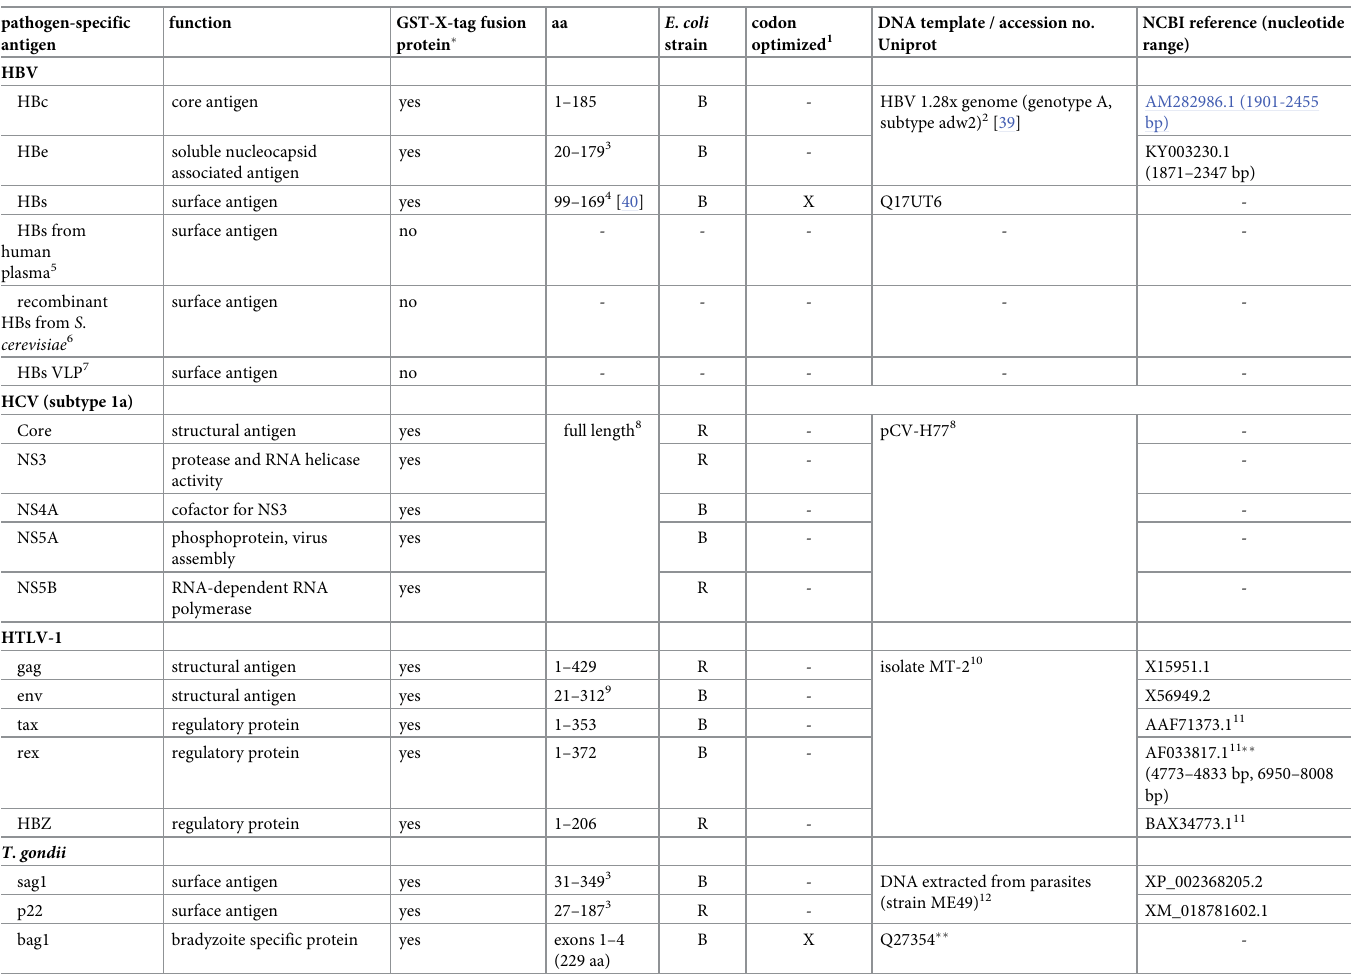
Table 1. Characteristics of selected pathogen-specific serology antigens. pathogen-specific